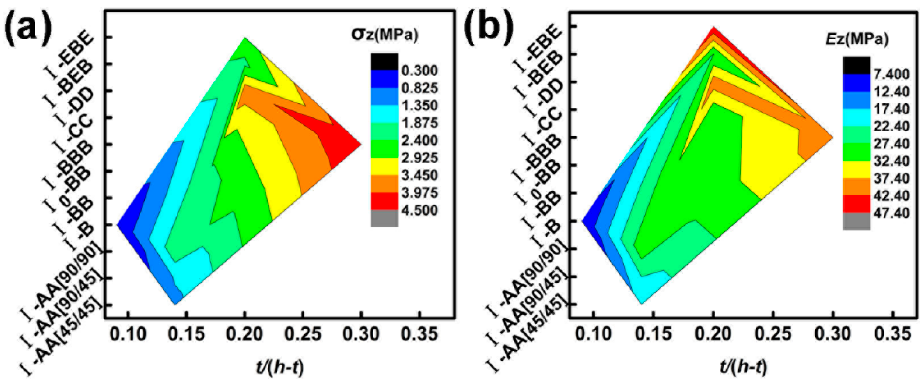
Figure 11. ( a ) Strength–length-to-diameter ratio–configuration comparison diagram ( b ) Young’s modulus–length-to-diameter ratio–configuration comparison diagram.